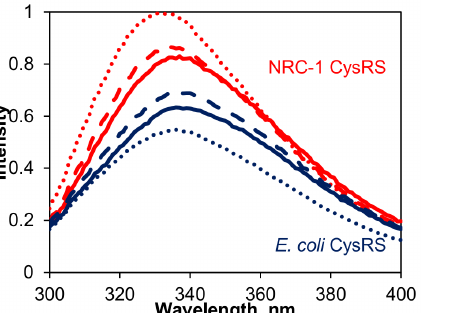
Figure 3. Intrinsic fluorescence emission spectra of NRC-1 (red) and E.coli(blue) CysRS. Fluorescence spectra of NRC-1 and E. coli CysRS using an excitation wavelength of 280 nm in various concentra- tions of KCl. The solid line represents the spectra collected in 0 M KCl, the dashed line represents the spectra in 500 mM KCl, and the dotted line represents the spectra collected in 3 M KCl.